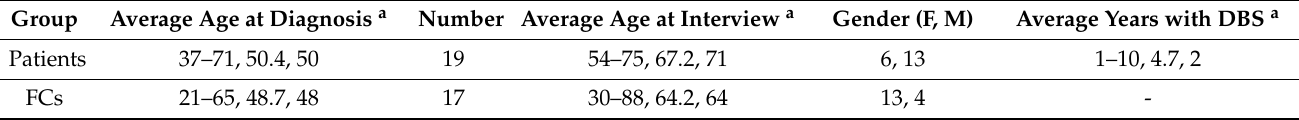
Table 1. Description of DBS patients and FCs. a Averages are given in the order range, mean, and median. Group Average Age at Diagnosis a Number Average Age at Interview a Gender (F, M) Average Years with DBS a Patients 37–71, 50.4, 50 FCs 21–65, 48.7,